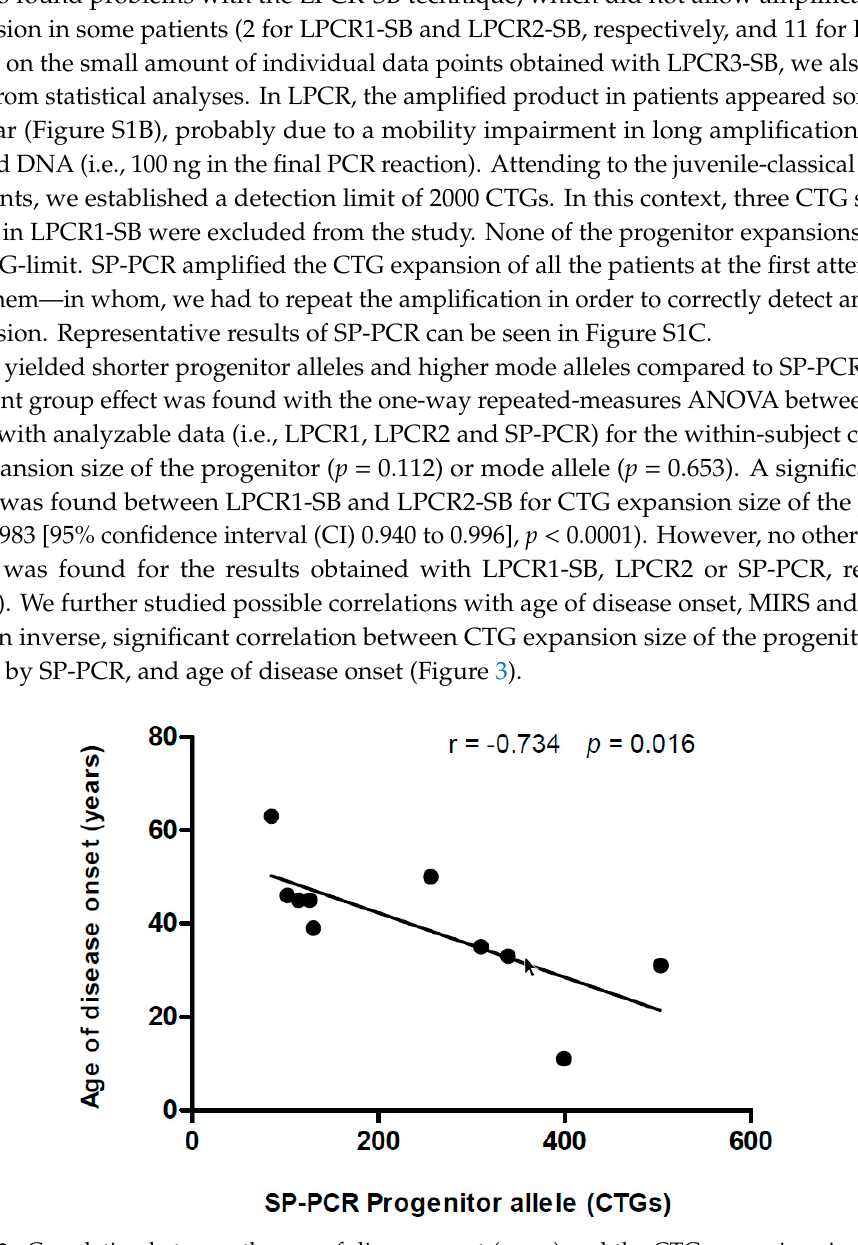
Figure 3. Correlation between the age of disease onset (years) and the CTG expansion size of the progenitor allele obtained through SP-PCR. The 95% confidence interval for the Pearson correlation coe ffi cient was − 0.933 to − 0.1940 (r = − 0.734, p = 0.016).